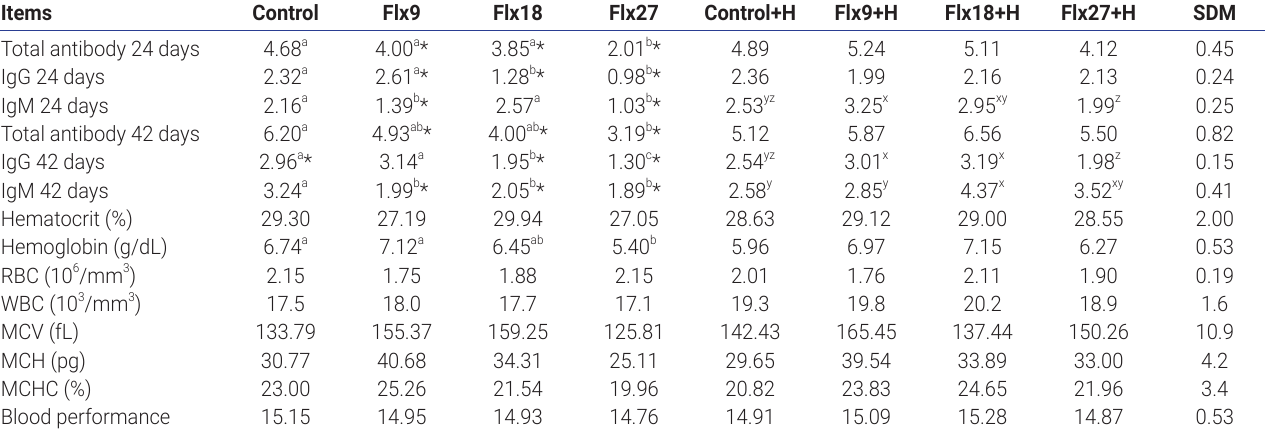
Table 8. Haematology and immune response of laying hen were fed test diets with different levels of extruded flaxseed with and without herbal medicines for nine weeks